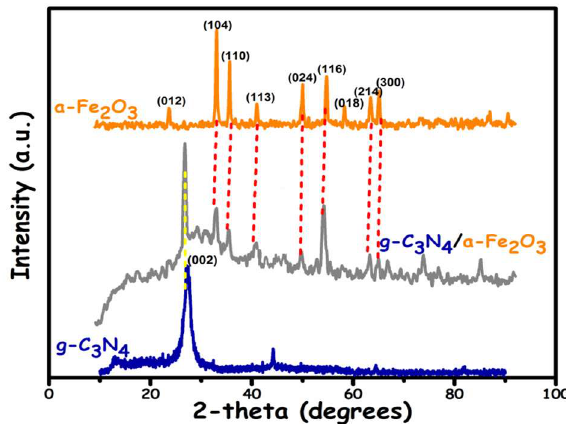
Figure 1. The XRD patterns.